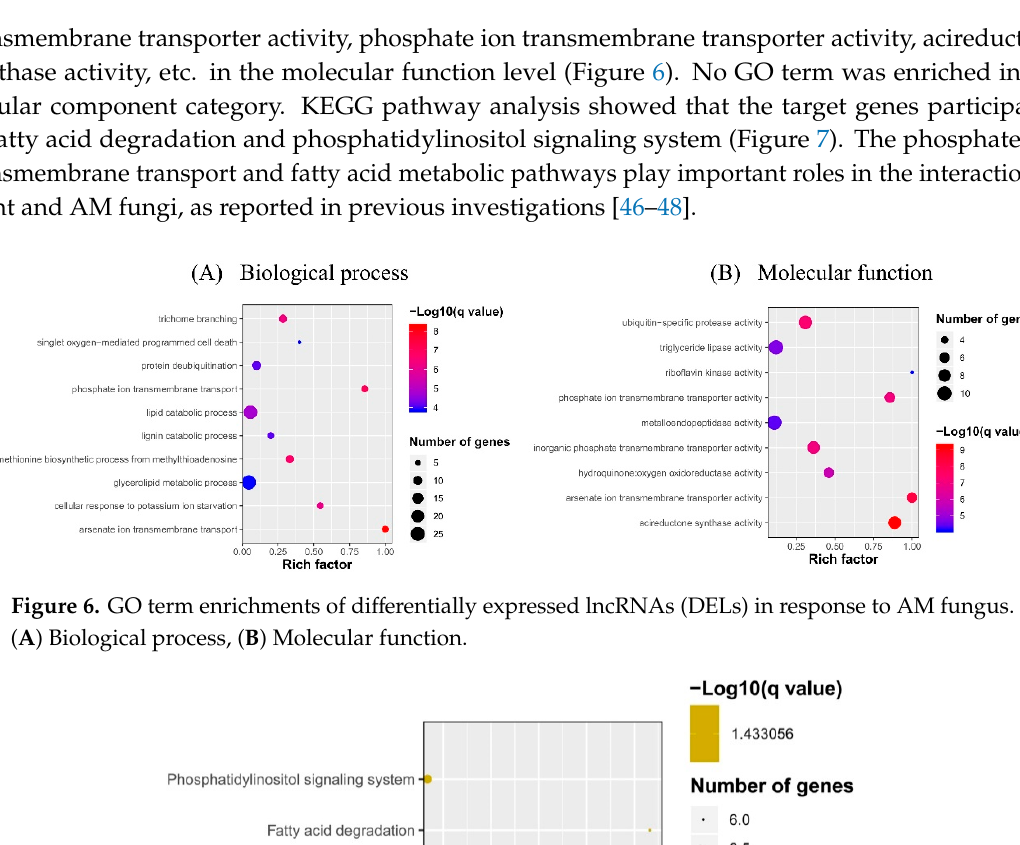
Figure 6. GO term enrichments of differentially expressed lncRNAs (DELs) in response to AM fungus. ( A ) Biological process, ( B ) Molecular function.